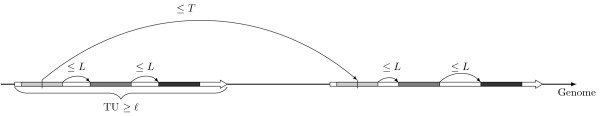
Structure of detected Tandem Arrays. An abstract representation of the structure of a Tandem Array with two Tandem Units that could be detected by Red Tandem. Every Tandem Unit has a minimum length ℓ and is separated from other Tandem Units in the array by less than T bases. Alignable units are reconstructed as a sequence of short similar segments (anchors) separated by less than L bases. In the Arabidopsis thaliana evaluation, we used ℓ = 500bp, T = 150kb and L = 40kb.